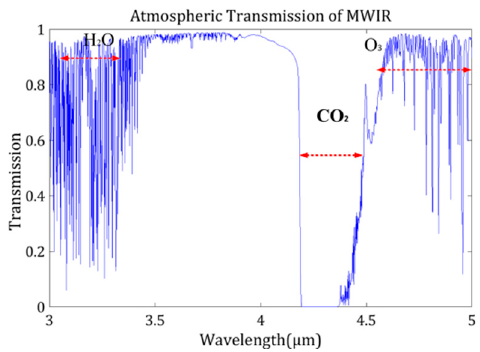
Figure 1. Atmospheric transmission in the mid-wave infrared (MWIR) region.